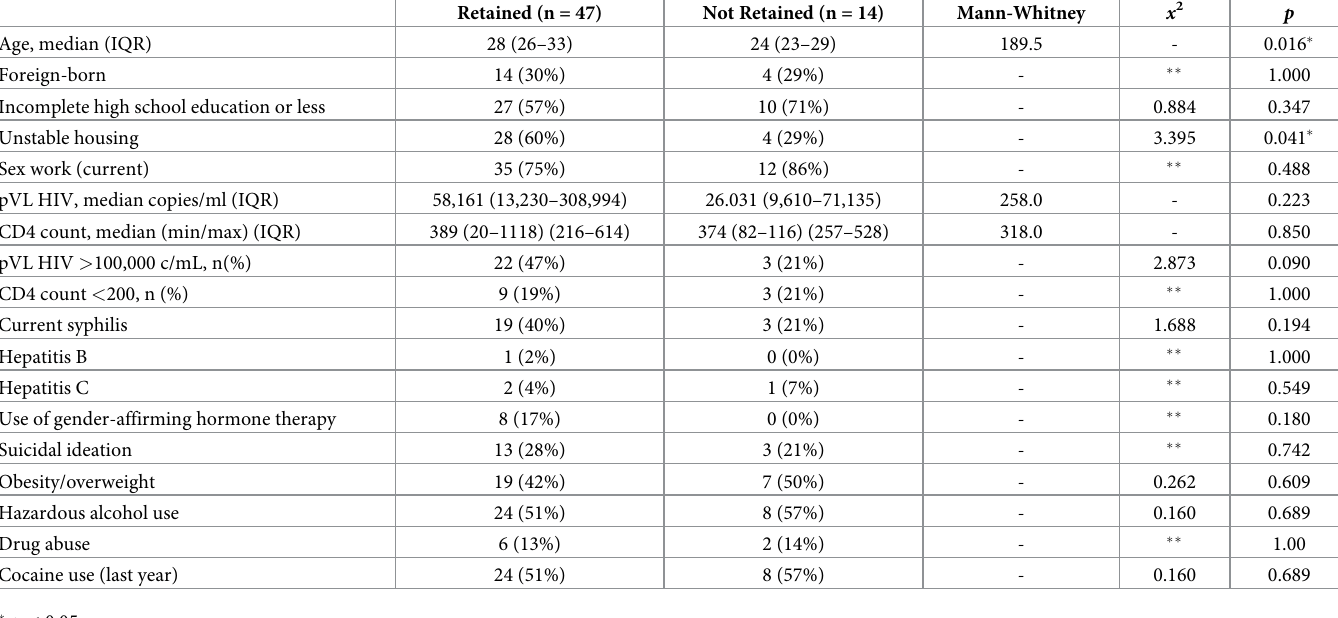
Table 3. Baseline clinical and psychosocial characteristics by retention status among HIV positive